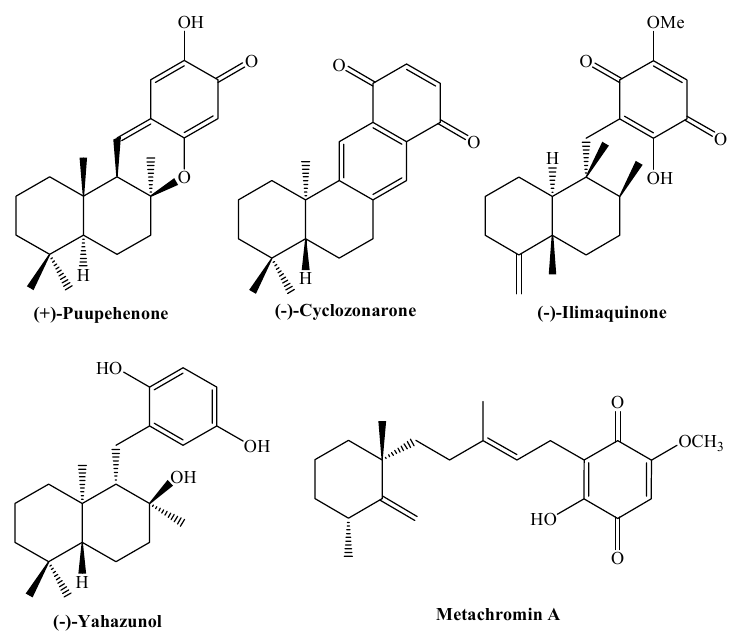
Figure 1 . Structure of some natural